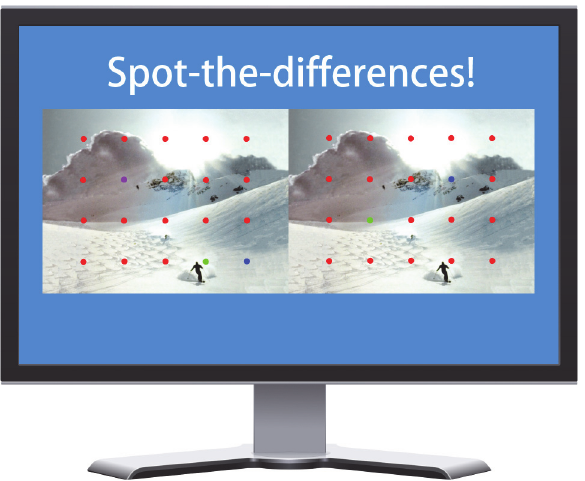
Fig 1. Spot-the-differences task display. The spot-the-differences task required counting the number of dots that differed between two copies of a picture (i.e., 5 in the illustration).